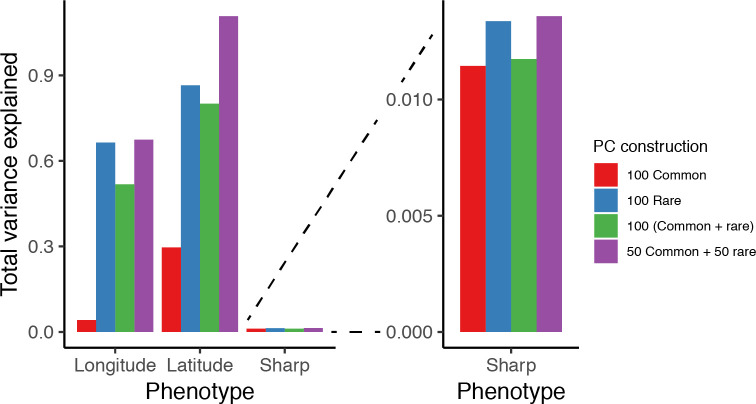
PCs computed from a single genetic relatedness matrix (GRM) constructed from common and rare variants together are different in how they capture population stratification than PCs computed from GRMs constructed separately from common and rare variants.(A) Variance in longitude, latitude, and the sharply distributed phenotype explained by 100 PCs under the complex demographic model. PCs explain more variance in longitude and latitude than in the Sharp phenotype because it is difficult to express the latter as a linear combination of PCs. Note, that PCs explain more variance in latitude than in longitude. This is because under the complex structure model, there is ancestry stratification in the north-south direction in addition to recent structure due to isolation by distance. Importantly, PCs computed separately from common and rare variants explain more of the structure than PCs computed from a single GRM constructed from common and rare variants together. (B) Variance explained in the sharp phenotype.